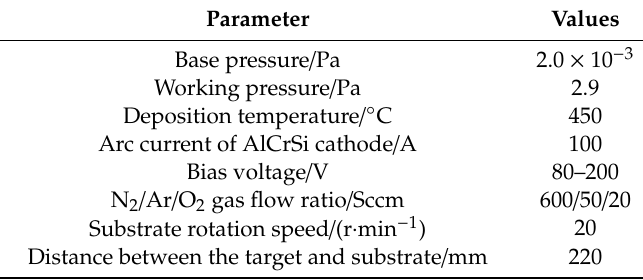
Table 1. Detailed deposition parameters for the AlCrSi(O)N coatings prepared by arc ion